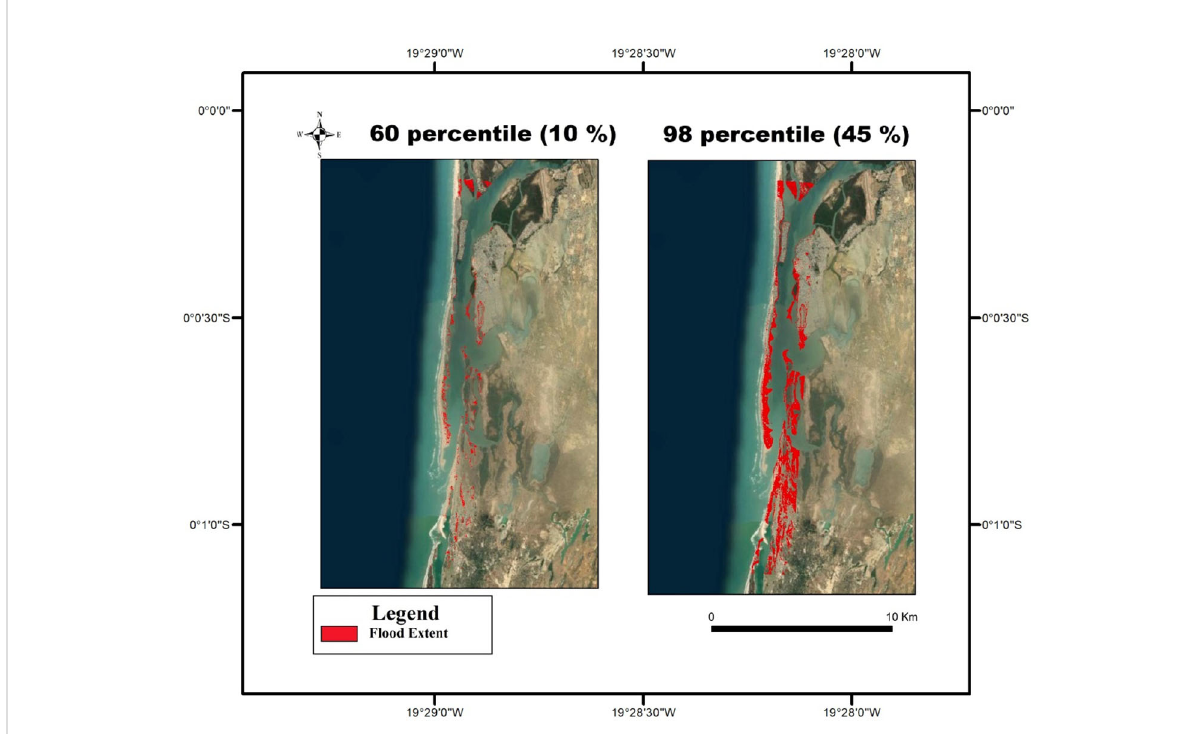
FIGURE 3 Spatial extent (red) of potential fl ooding for the moderate and severe ECWL scenarios, i.e. the 60th and 98th